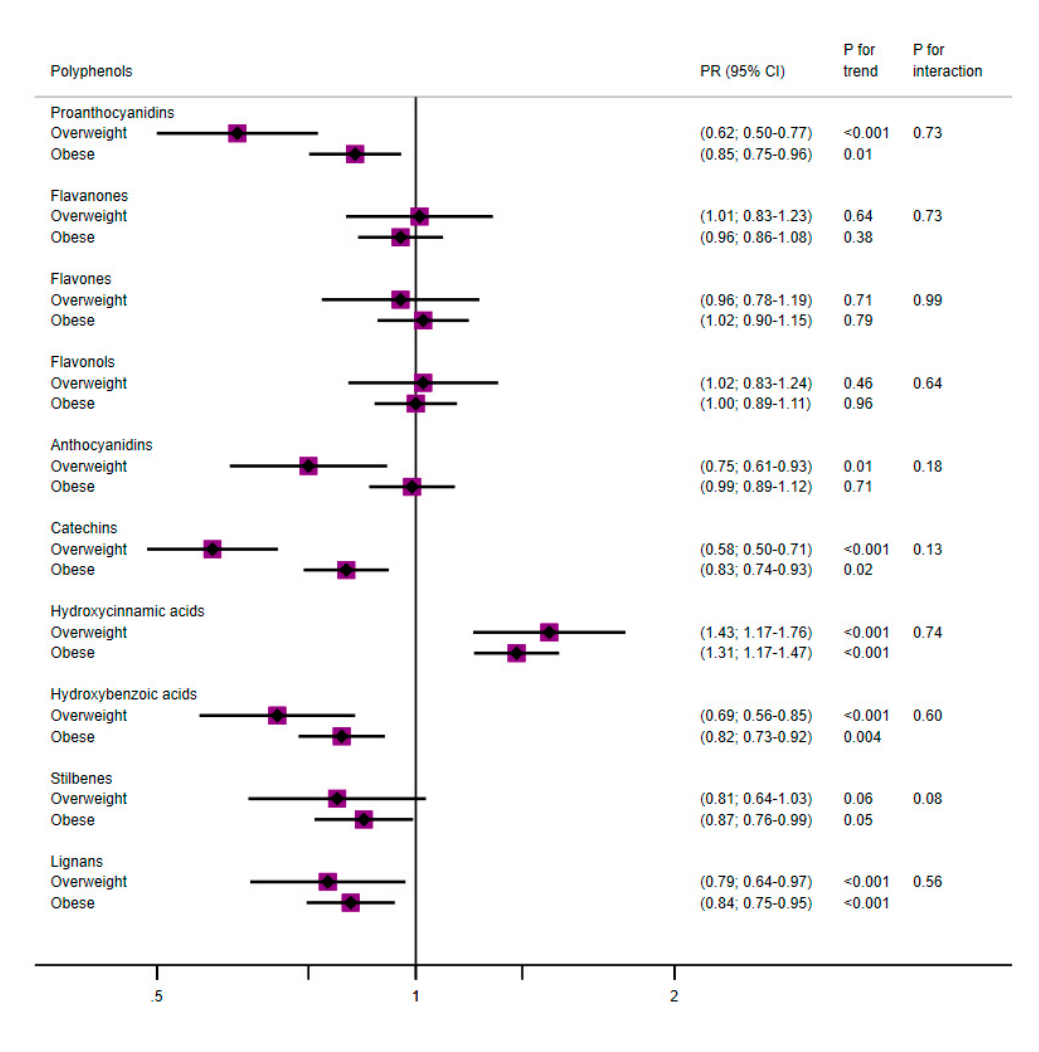
Figure 2. Cox proportional models for polyphenol groups and T2D by BMI groups, comparing Q4 vs. Q1 and adjusted for sex, age, education (basic studies, medium, high), smoking (never, former, smoker), physical activity (quintiles), energy, consumption of refined cereals and animal products (from 17-point questionnaire) and of distilled beverages and liquors, sugar, soft drinks, cookies, and pastries (g/day), and stratified by recruitment center.